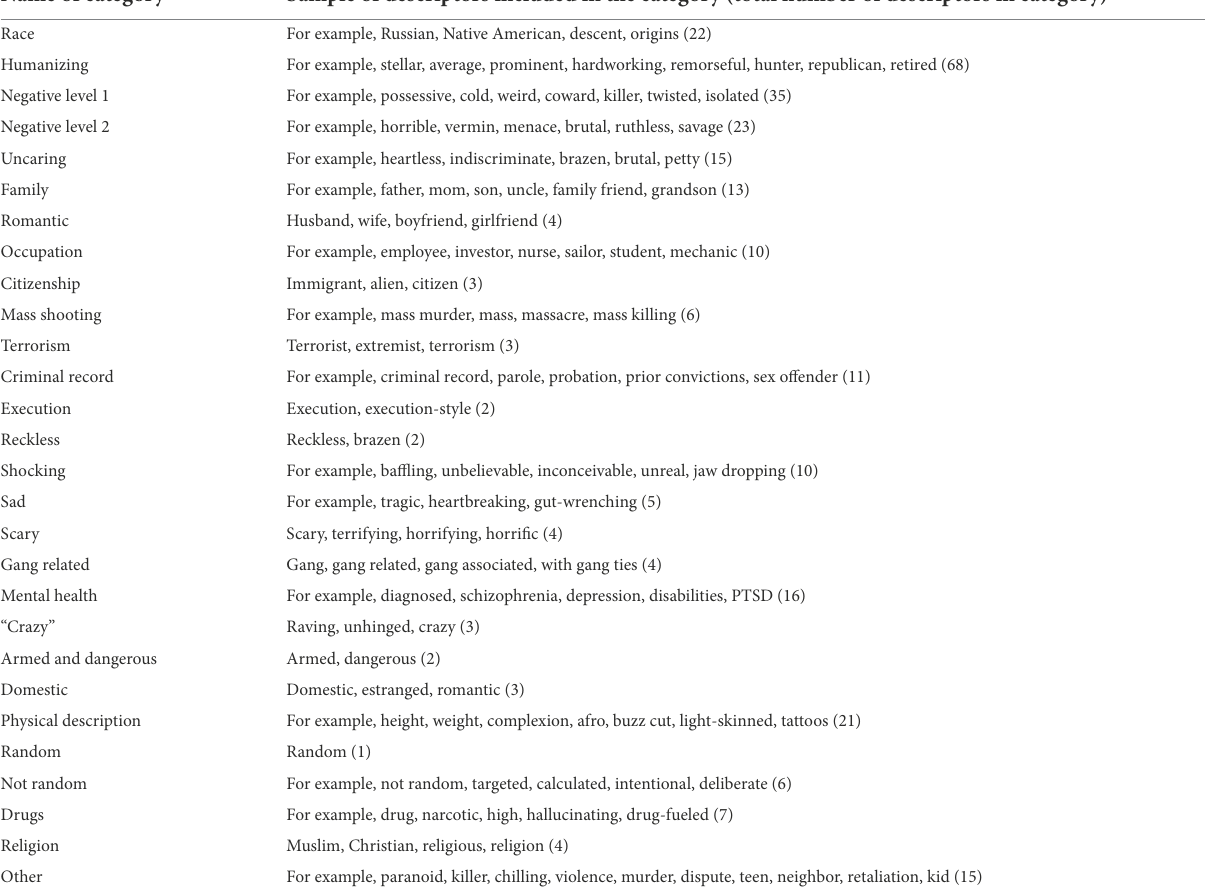
TABLE 1 Descriptor categories for mass shooting media coverage.